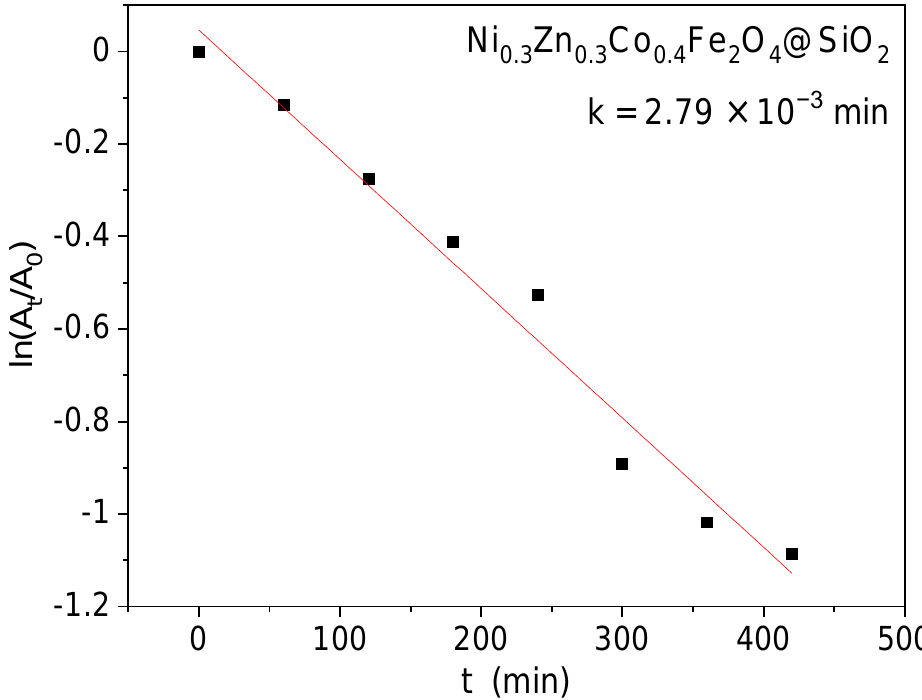
Figure 7. Photodegradation kinetics of RhB in the presence of Ni 0.3 Zn 0.3 Co 0.4 Fe 2 O 4 @SiO 2 .